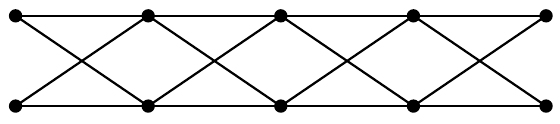
Fig. 2. A four-wire Hoytether. Wire bonding sites are shown by dots. The width of the structure is typically